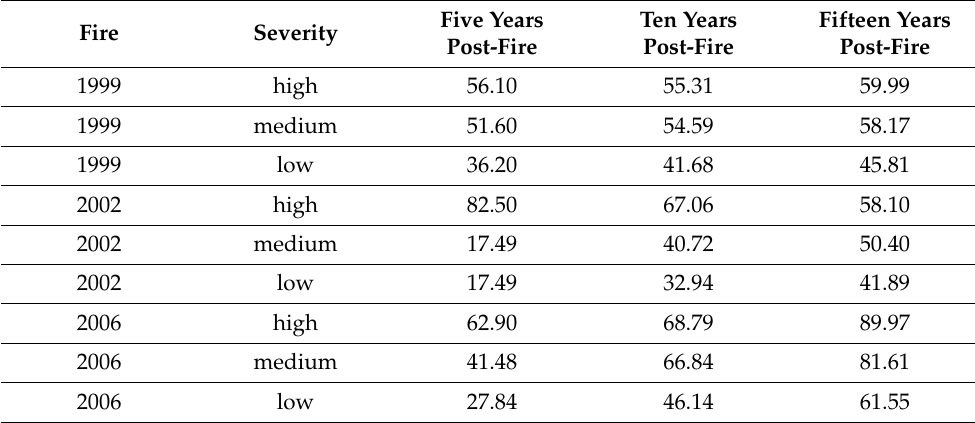
Figure 3. Post-fire %NBR recovery by burn severity. Table 4. Post-fire %NBR recovery by burn